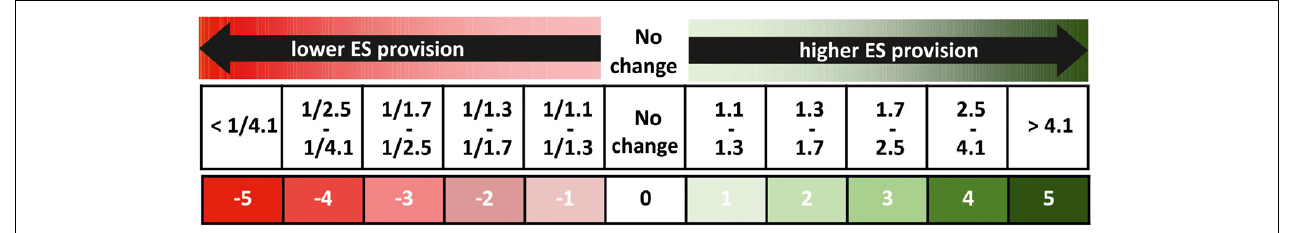
FIGURE 3 | The relative scoring system indicates changes between two different periods in time. For example, the score 1, indicating a slightly higher ES provision, is given when the increase in the present state is higher by a factor of 1.1–1.3 compared to a historic